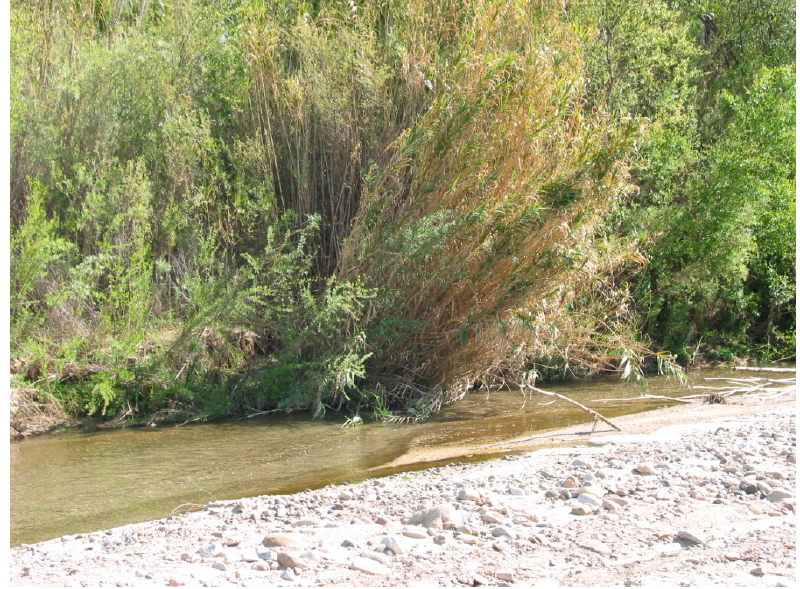
Figure 17. Bank failure: Cantilever bank failure in 2009 (site S1) caused by A. donax being undercut below the tough near-surface root system.